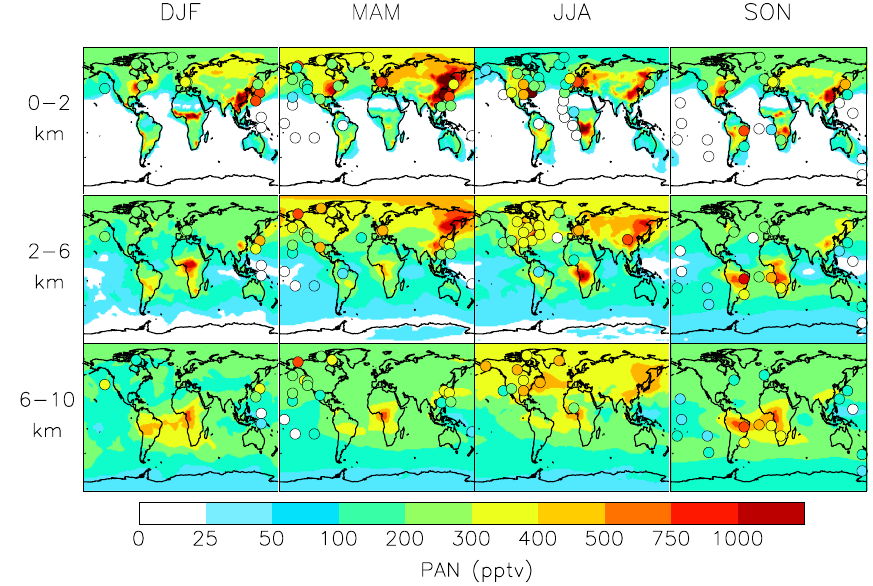
Fig. 2. Global mean distribution of PAN for different seasons and altitude ranges. Model results for 2008 (background solid contours) are compared to observations from Table 2 for all years (filled circles). Aircraft observations are averaged vertically and horizontally over the coherent regions of Figure 2.